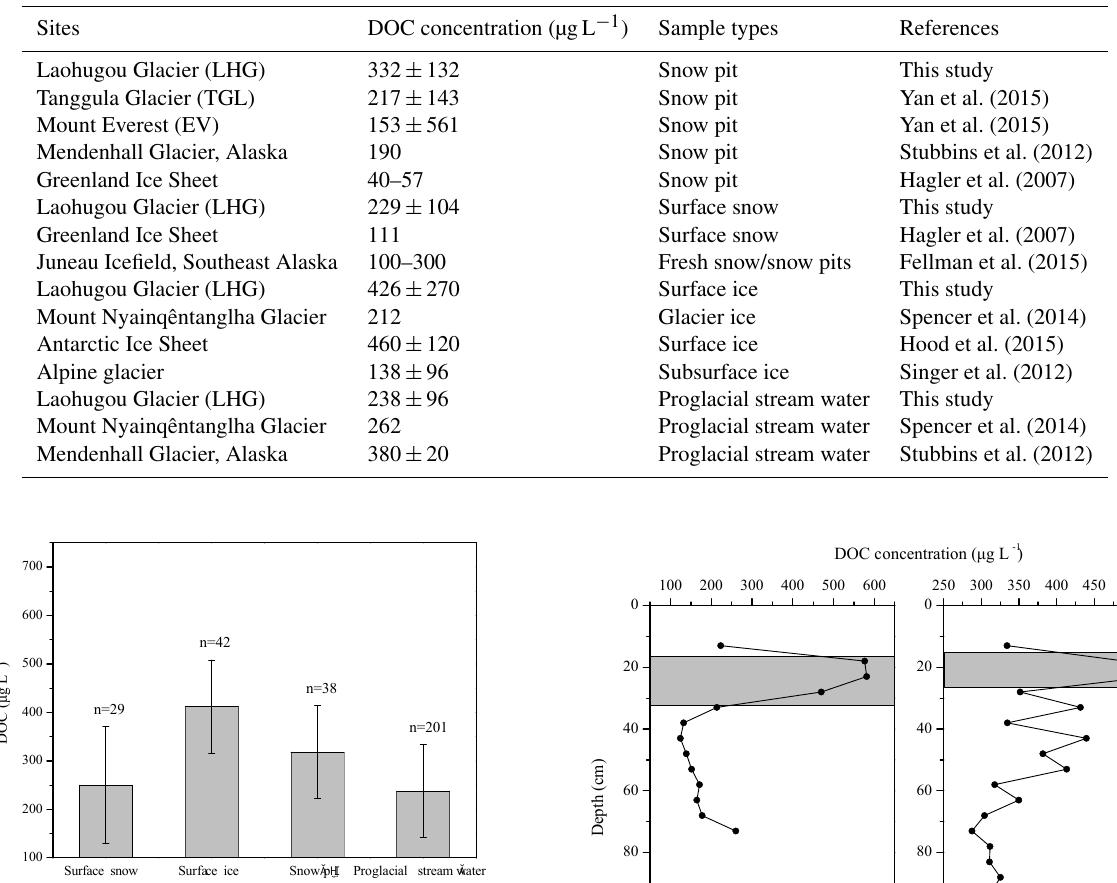
Table 2. Comparison of DOC concentrations in snow, ice and proglacial stream water from the glacier in this study and glaciers in other regions.